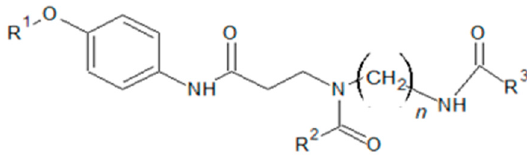
Figure 3. Common structure of each substrate and internal standard. Table 3. Chemical structure and final concentration of substrate and internal standard for each enzyme.